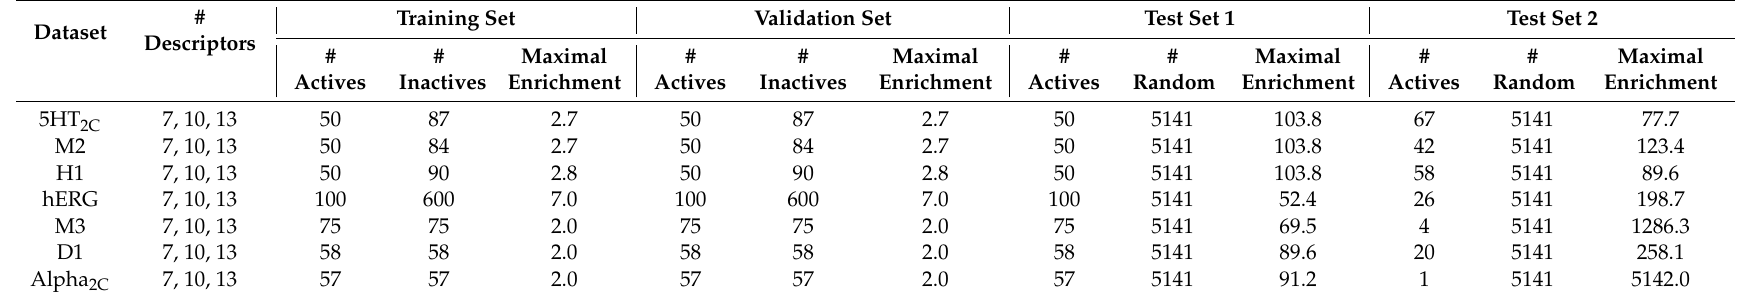
Table 5. Description of the seven datasets used for the derivation of Multiple Linear Regression (MLR) models. The “Maximal Enrichment” column provides the maximal possible enrichment at L , attainable for the data set for a comparison with the enrichment values provided in Tables 1 and